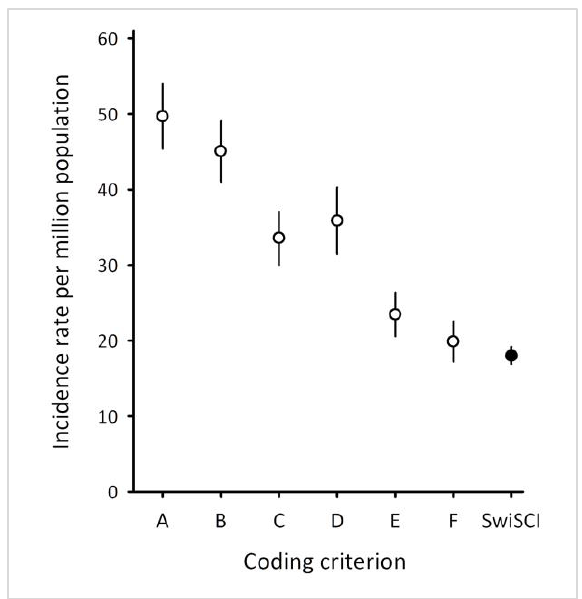
Figure 3: Overall annual incidence rate estimates including 95% confidence intervals. The incidence rate point estimate is indicated by a circle; the filled-in circle is the estimated in- cidence rate in the paper by Chamberlain et al. [7], which used the rehabilitation-based SwiSCI data to estimate the incidence rate. Error bars represent the 95% confidence in- terval.